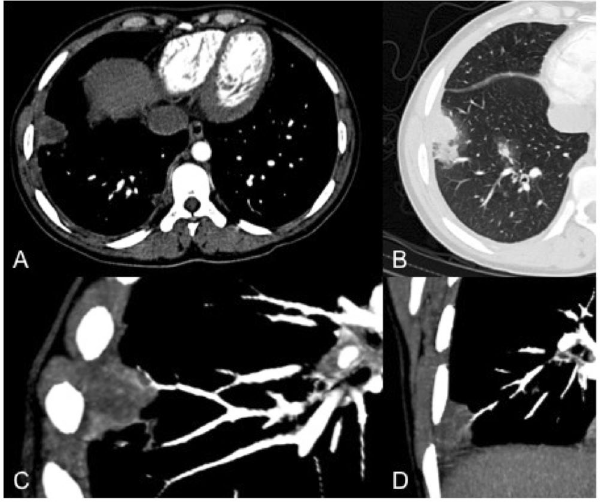
Figure 1. Computed tomography pulmonary angiography (CTPA) study of a 29-year-old male, immunocompromised patient. The infarct shaped subpleural consolidation showed central low attenuation ( A ) with a surrounding peripheral halo sign ( B ). CTPA showed vessel interruption within the lesion ( C , D ).